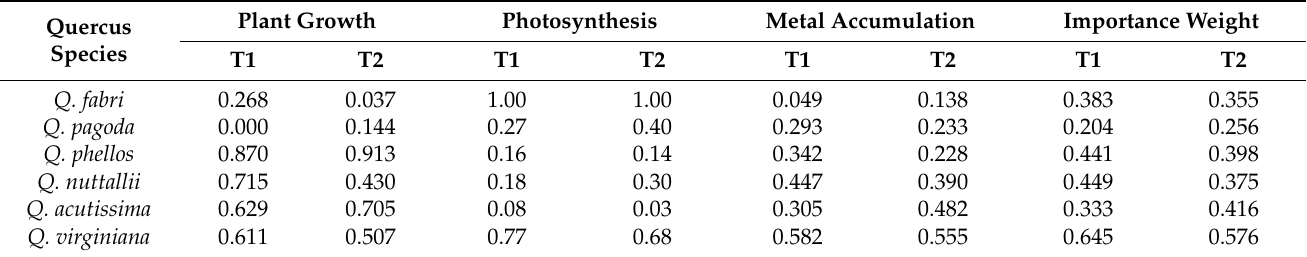
Table 4. Importance weights of different criteria in T1 (mixture of clean and polluted soil, 50%) and T2 (100% polluted soil)